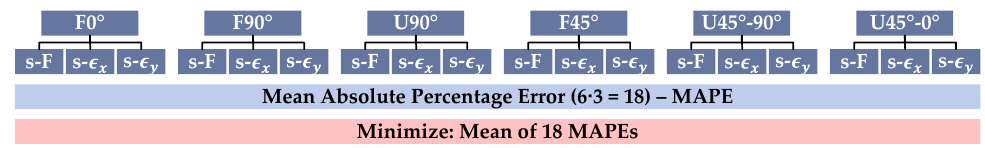
Figure 8. Fitting: Aggregation of error measures in detail.